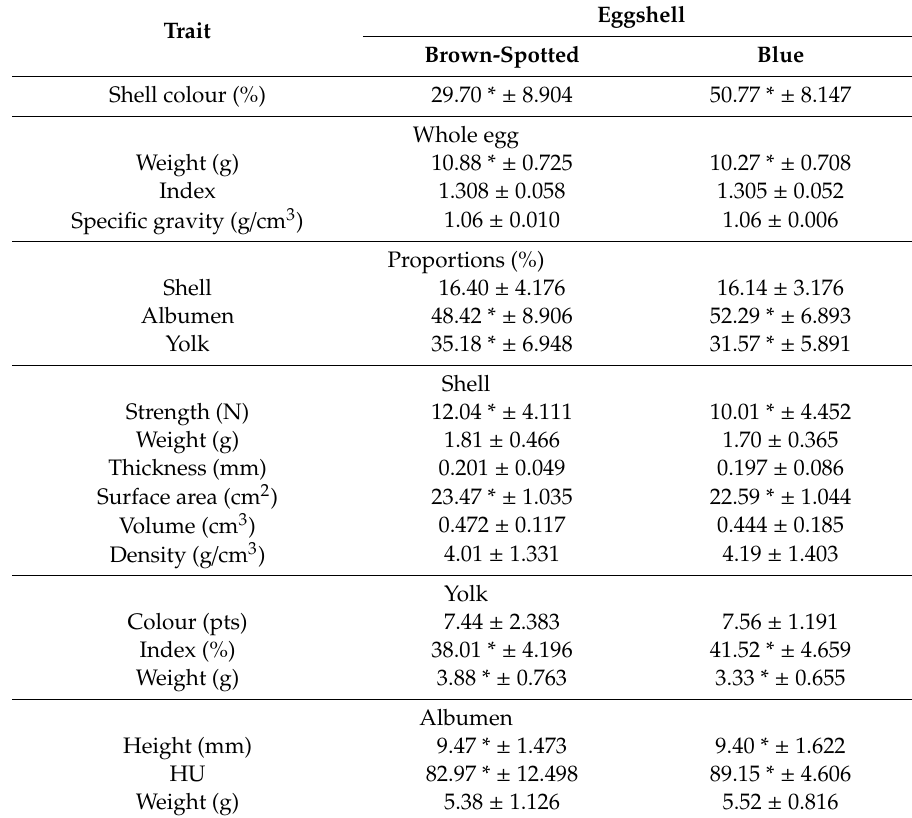
Table 1. The di ff erentiation of quality characteristics of Japanese quail table eggs depending on the eggshell colour (mean ± standard deviation (SD)).